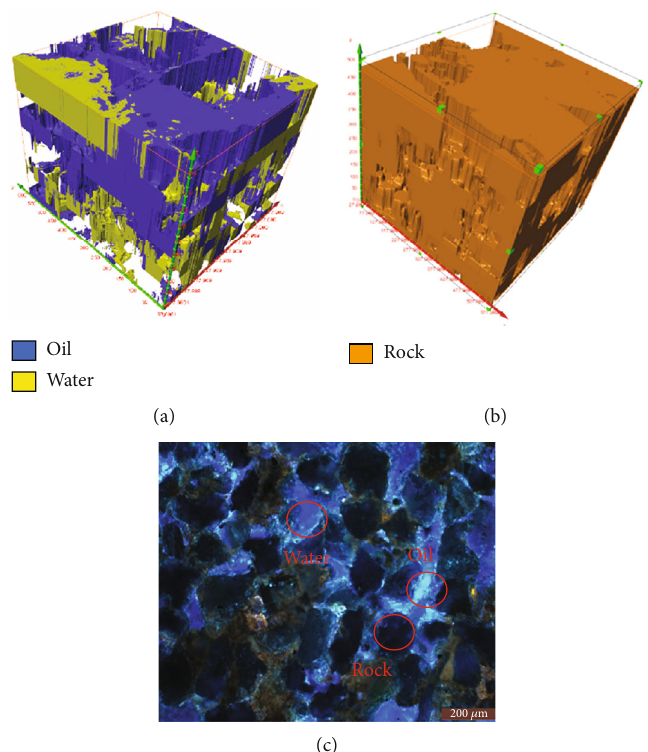
Figure 8: Three-dimensional distribution characteristics of microscopic oil – water rocks. (a) Three-dimensional reconstruction image of oil – water spatial distribution. (b) Three-dimensional reconstruction image of spatial distribution of rock pores. (c) Fluorescent images of oily fl akes.